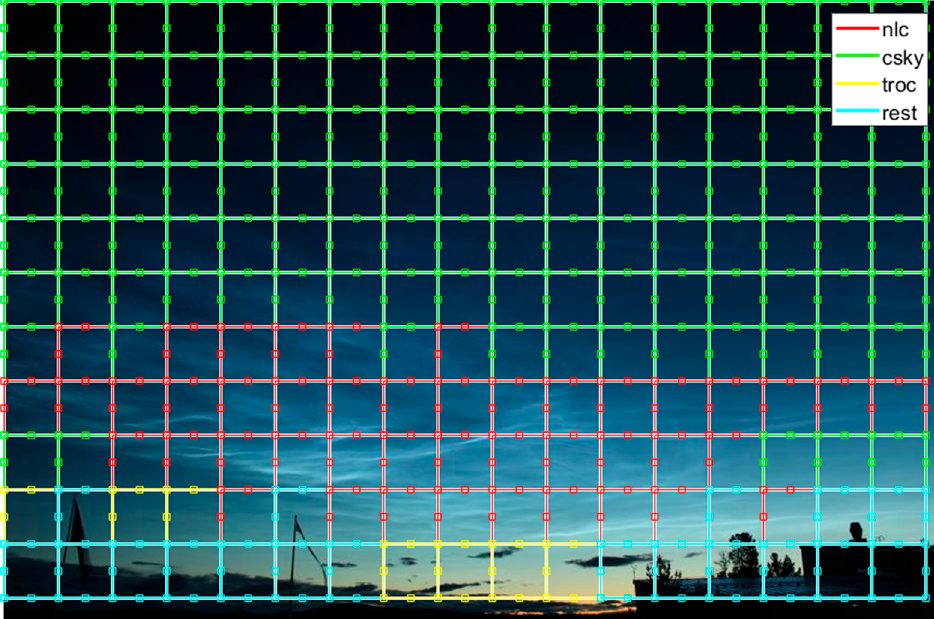
Figure 13. Very faint or low contrast noctilucent activity by the CNN algorithm.